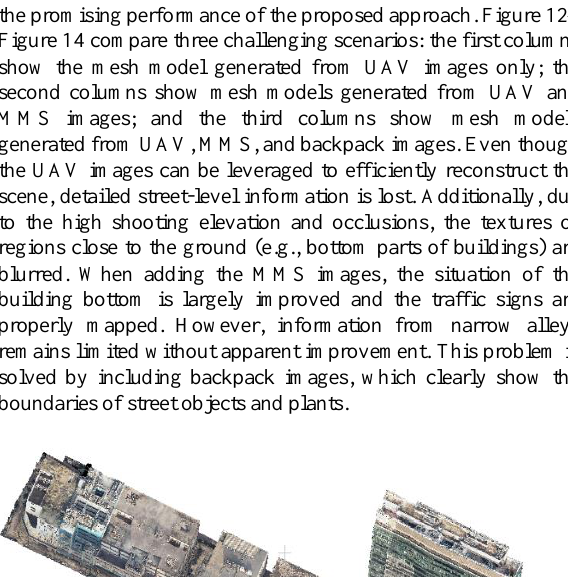
Figure 14 compare three challenging scenarios: the first columns